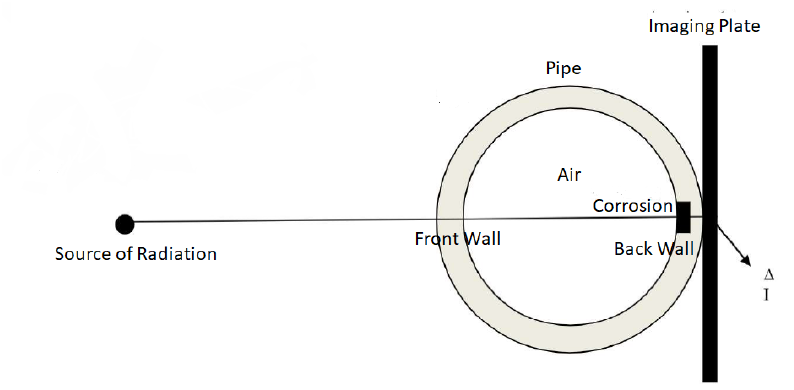
Figure 44. The setup for the evaluation of the thickness of the back wall of a pipeline using radiogra- phy. Reprinted under Creative Commons CC BY-NC-ND license